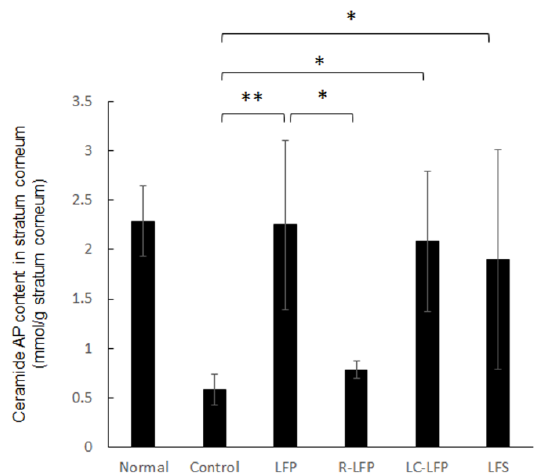
Figure 5. Ceramide AP content in the stratum corneum of regular and HR-AD-fed mice after oral administration of lactic acid bacteria metabolites for 40 days. * p < 0.05, ** p < 0.01 (Tukey’s post-hoc test).